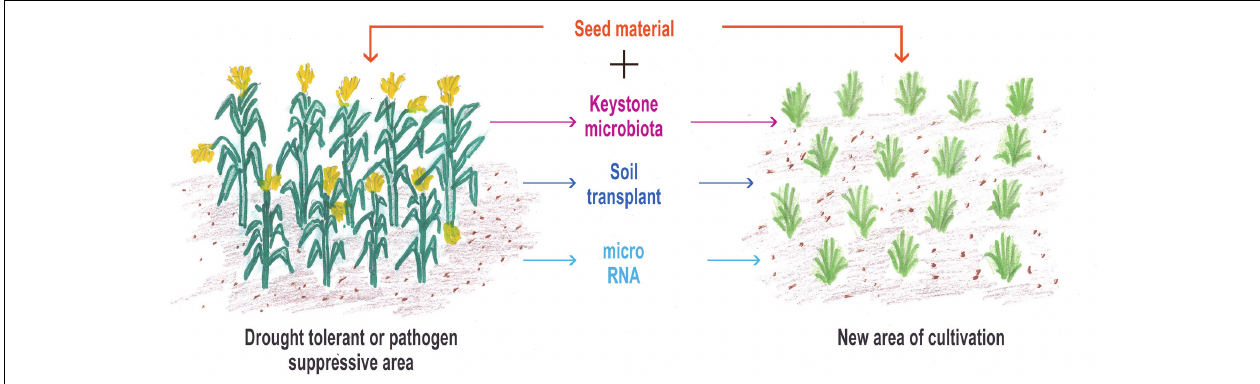
FIGURE 2 | This represents the direct (keystone microbiota and soil transplant) and the indirect methods (microRNA transfer) of co-propagating the microbiome with planting material from selected situations for raising next-generation